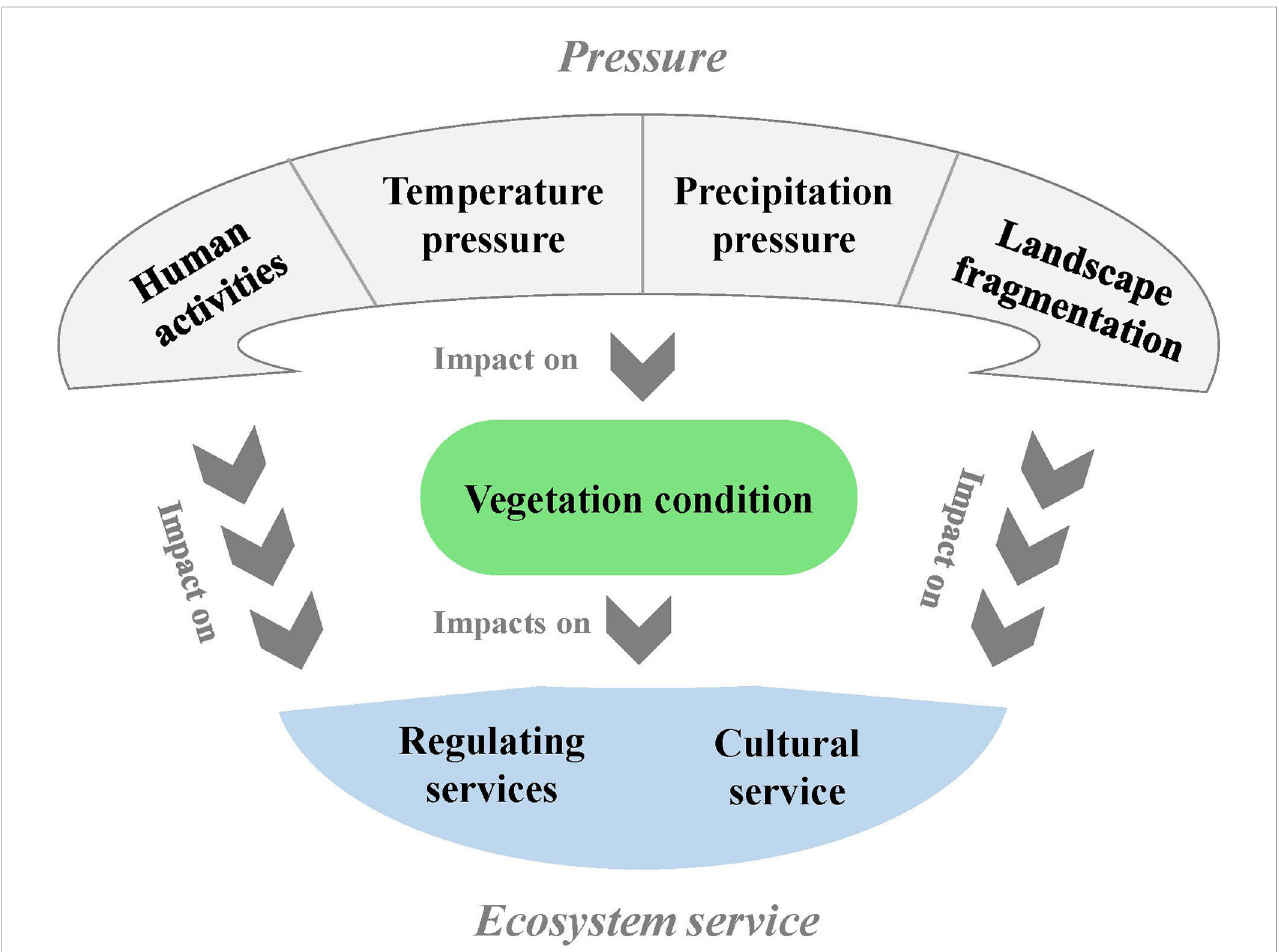
FIGURE 2 A conceptual SEM showing the possible relationship between pressure, vegetation condition and